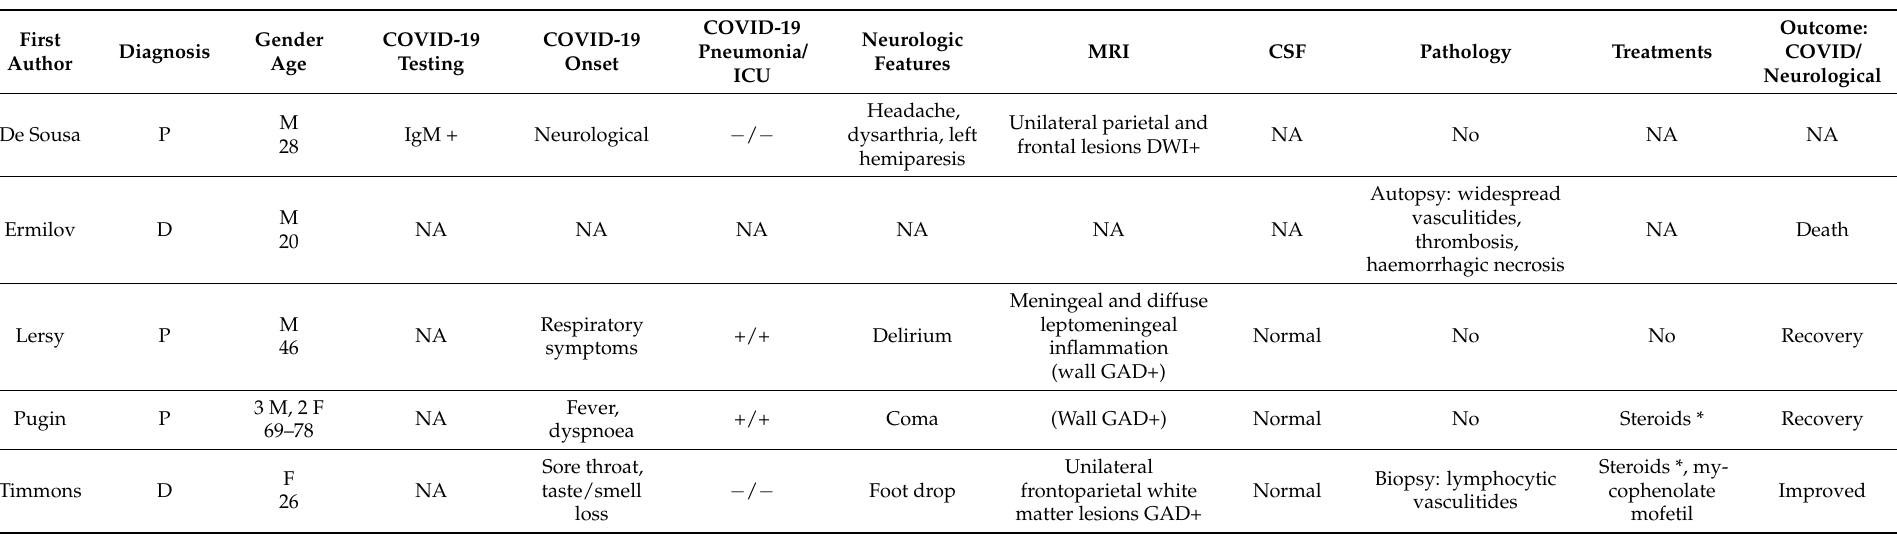
Table 2. Clinical characteristics of the 9 cases with no real-time polymerase chain reaction positive for severe acute respiratory syndrome